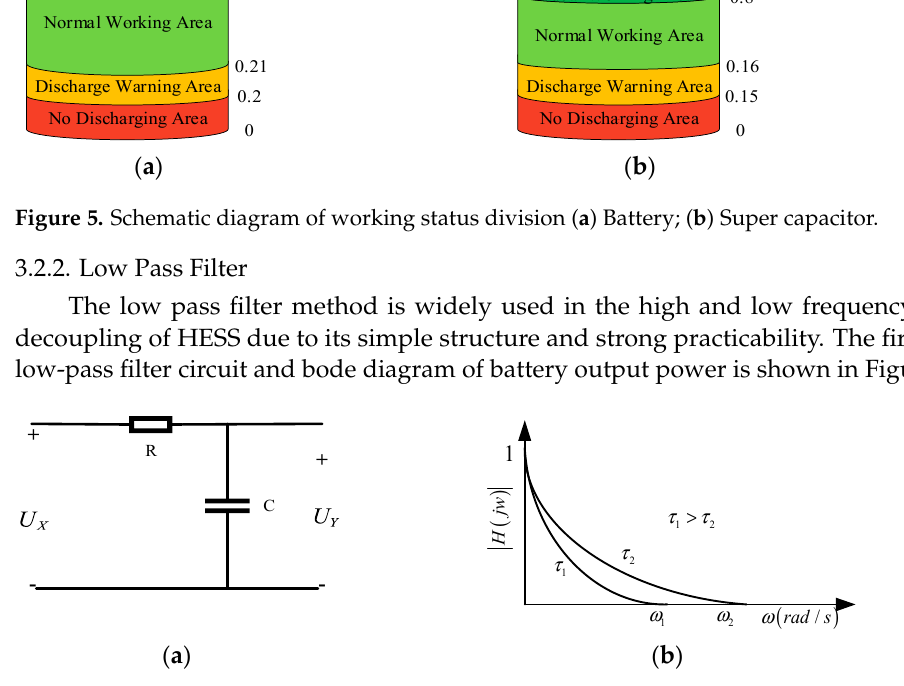
Figure 6. ( a ) Low-pass filter circuit diagram; ( b ) Bode diagram of battery output power.